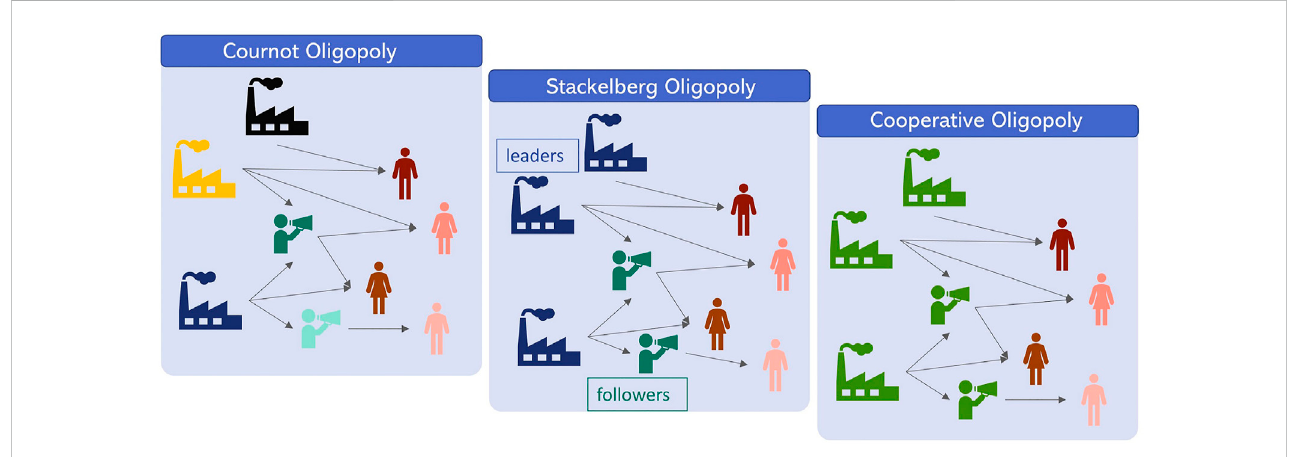
FIGURE 5 Conceptual representation of an Oligopolistic supply chain under different cooperation levels. Cournot Oligopoly: competitive game, Stackelberg Oligopoly: leader-follower game, Cooperative